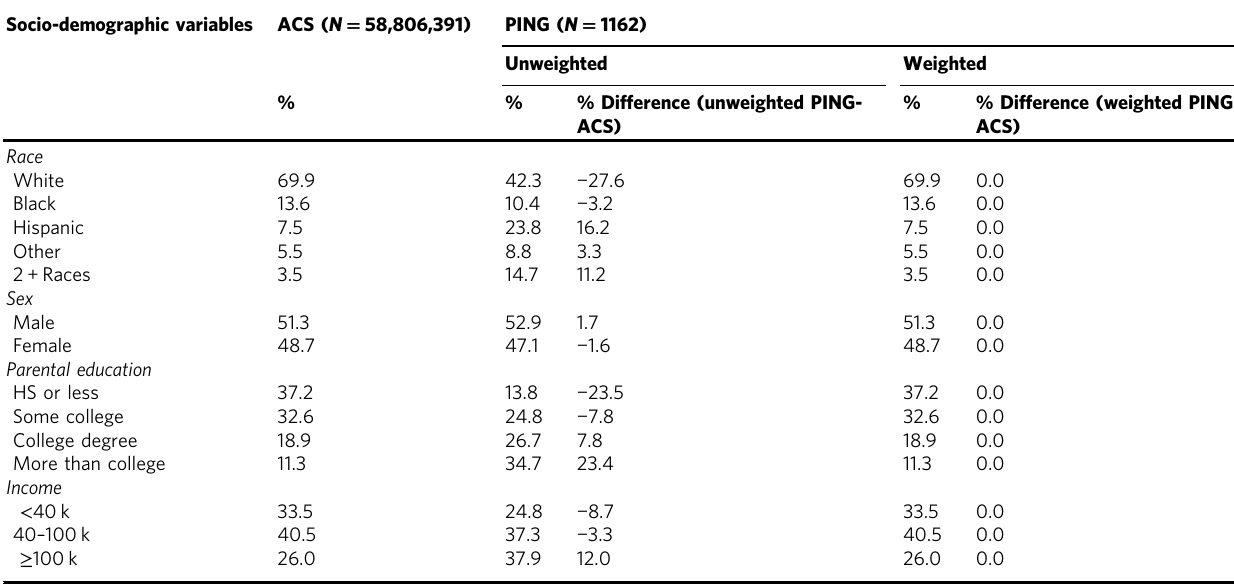
Table 1 Demographic characteristics in the United States and in the PING sample Socio-demographic variables ACS ( N = 58,806,391) PING ( N = 1162)